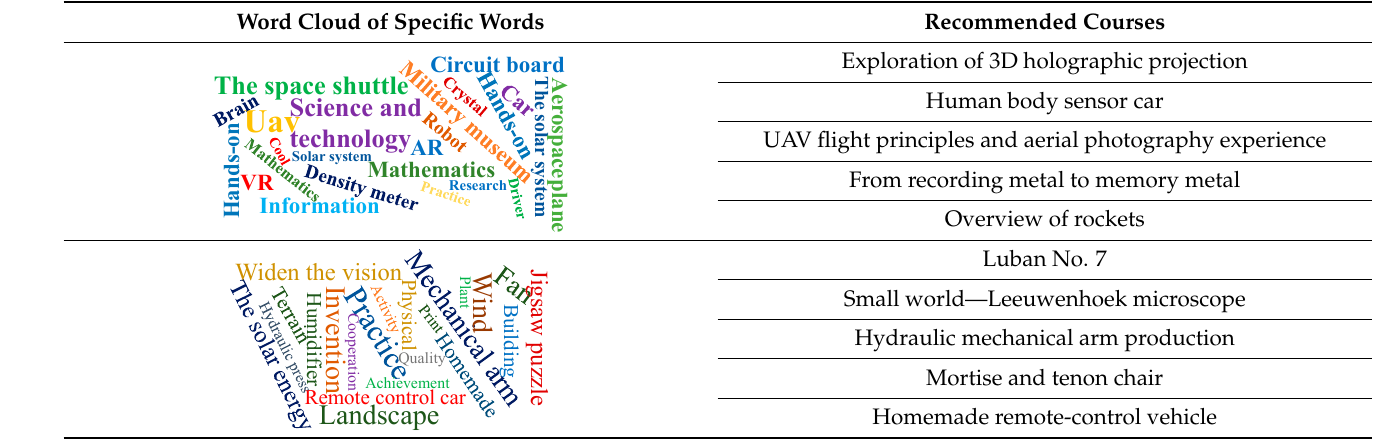
Table 6. Examples of feature words cloud and course recommendation results.